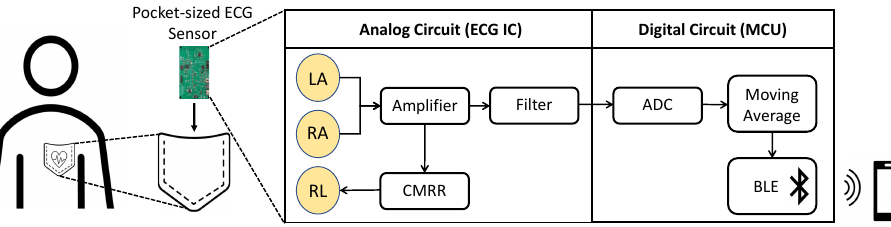
Figure 1. Representative usage case of the proposed device.